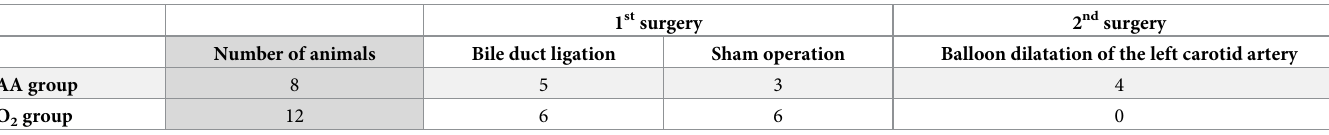
Table 1. Overview of the number of rats and the number of interventions included in the two study groups. 1 st surgery 2 nd surgery Number of animals Bile duct ligation Sham operation Balloon dilatation of the left carotid